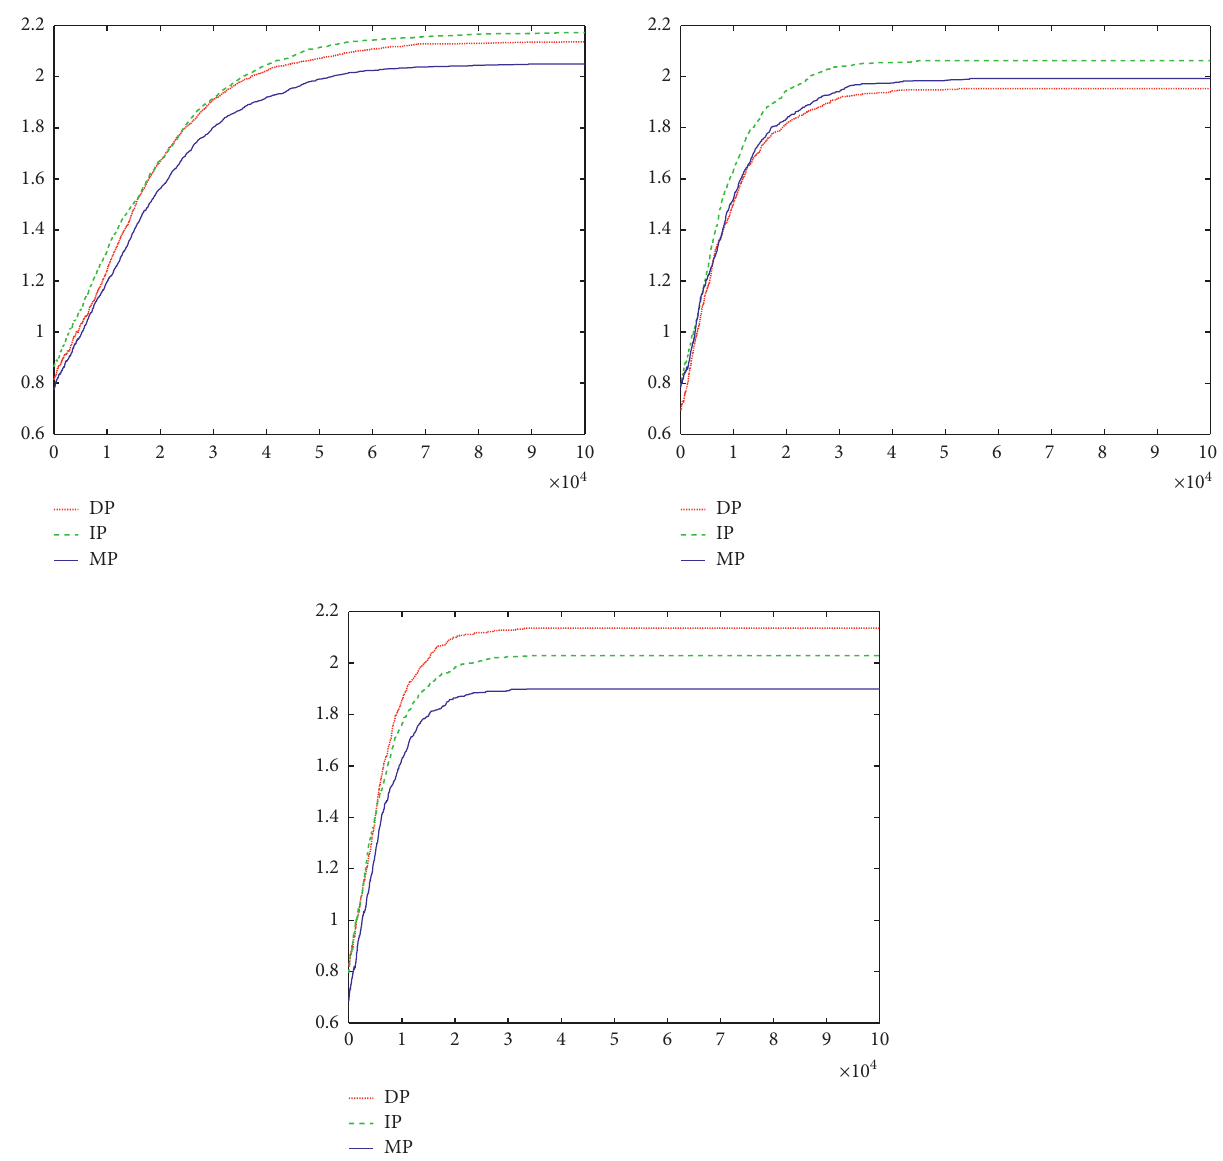
Figure 5: Knowledge equilibrium in a scale-free network when k � 2, 4, and